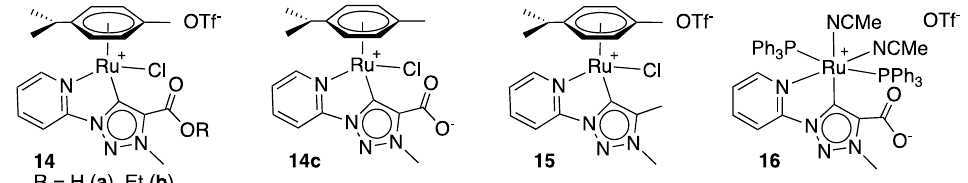
Figure 2. Pyridyl-functionalized triazolylidene complexes 14a – c and 16 bearing a pendant carboxylic group and unfunctionalized complex 15 .